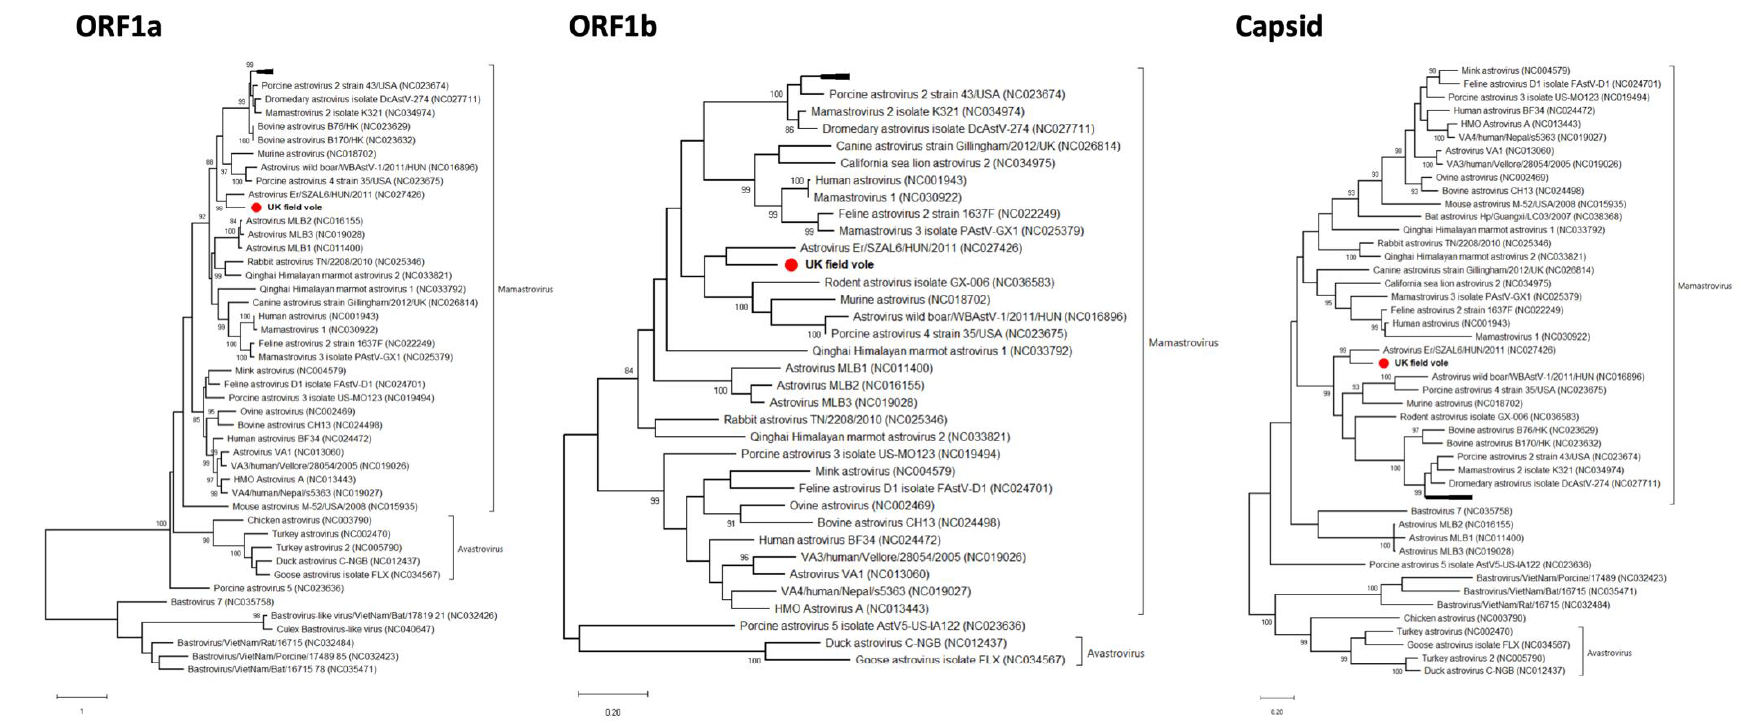
Figure 5. Phylogenetic relationships of the novel field vole astrovirus based on the ORF1a , ORF1b and capsid genes. The trees represent maximum likelihood phylogenetic analyses of astrovirus partial ORF1a (508 aa), ORF1b (298 aa) and capsid (350 aa) gene sequences. The novel sequence obtained from the UK field vole UKMa1 was analyzed alongside reference sequences representing all different genera of astroviruses. Reference sequences are indicated by their GenBank accession numbers. Branch lengths are drawn to a scale of amino acid substitutions per site. Numbers above individual branches indicate the bootstrap support; only values >80% are shown. The novel UK Ma 1 astrovirus is marked with a red dot. For clarity, some viral clades have been collapsed.